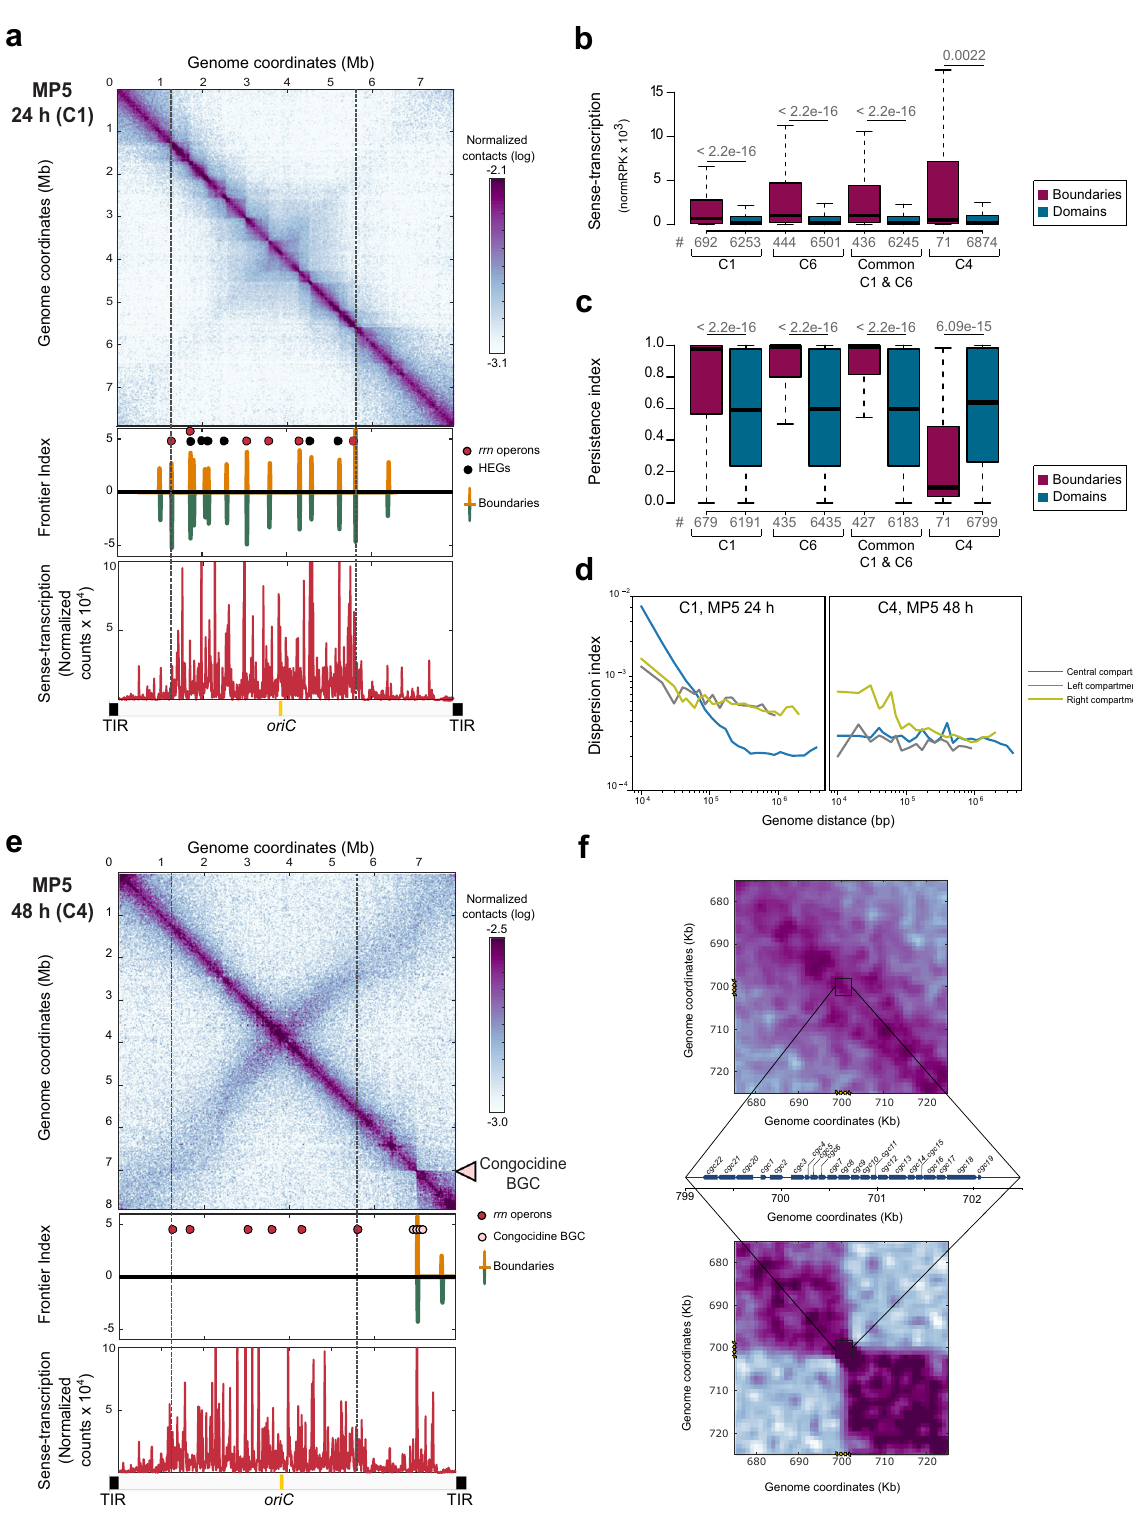
differentiation (Fig. 4c). In addition, a second boundary detected within the right compartment is located in the stambomycin BGC that is not or is poorly expressed in this condition. Interestingly, accompanying the formation of boundaries and the increase of transcription in the terminal compartments, the variability in the long-range contacts within the terminal compartments is com- parable to that of the central compartment (Fig. 4d).